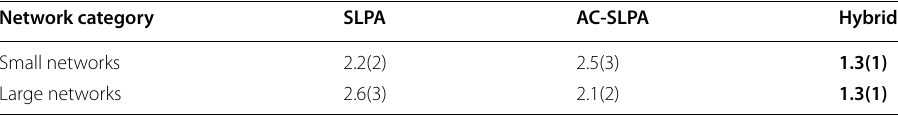
Table 15 Average ranks of NMI scores of AC-SLPA using the hybrid cleaning process, SLPA and AC-SLPA with noisy pairwise constraints on small and large synthetic networks Network